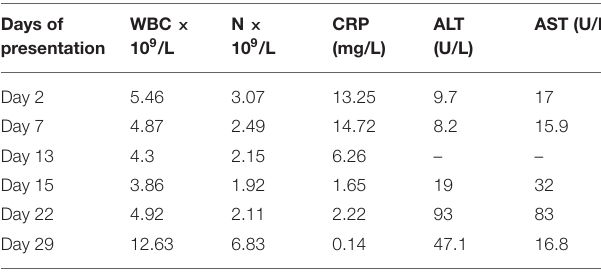
TABLE 1 | Laboratory findings during the course of illness in the